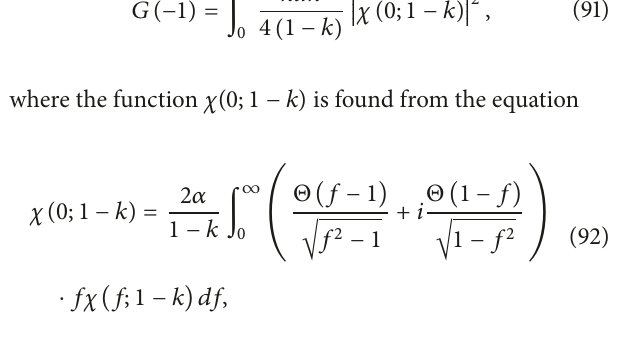
Figure 9: The 2𝛾 angular correlation spectrum for the reaction (62). The angle 𝜙 = 𝜋 − 𝜗